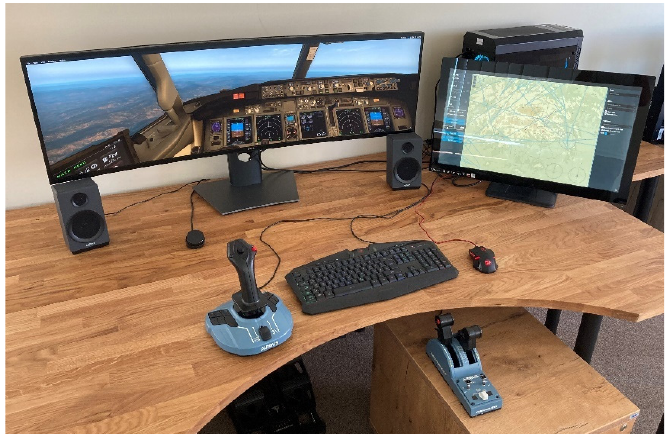
Figure 8. Stationary simulator station.